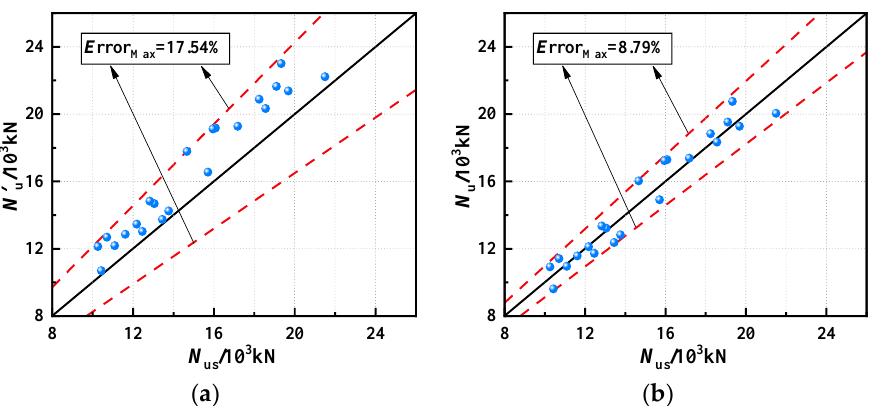
Figure 21. Comparison between N´ u , N u and N us . ( a ) Comparison between N u and N us . ( b ) Compar- ison between N u and N us . Table 6. Comparison between N´ u , N u and N us .